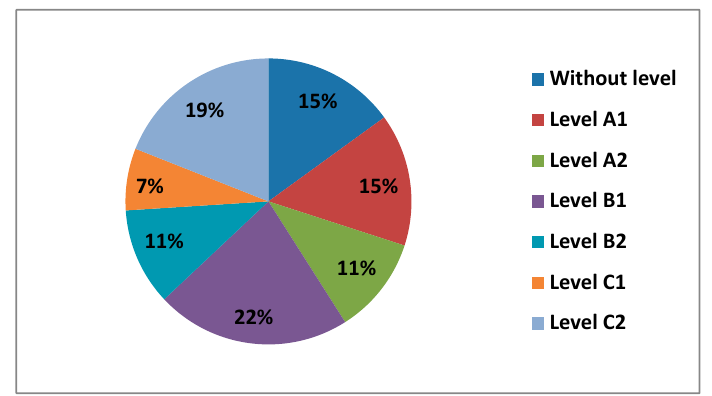
Figure 22. Level of digital competence in teachers in Area 4.